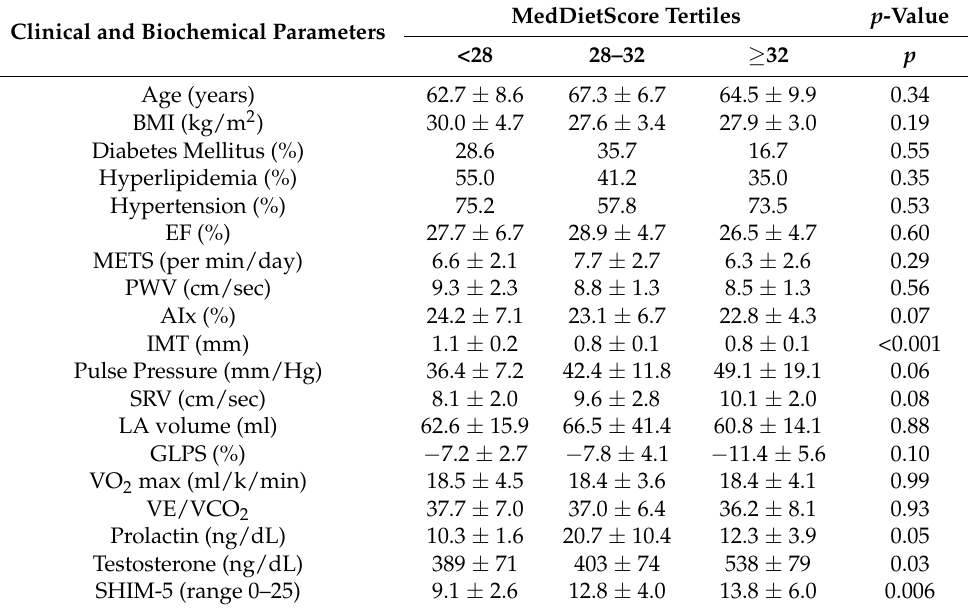
Table 1. Demographic and clinical characteristics, ultrasound and exercise test measurements by Mediterranean diet score (MedDietScore) tertile. MedDietScore Clinical and Biochemical Parameters